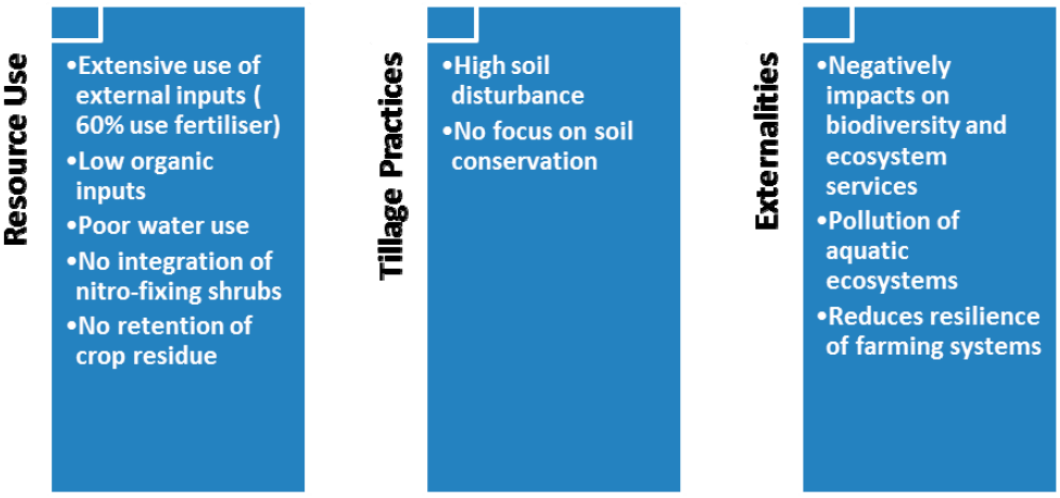
Figure 3. Features of conventional farming in the study area.